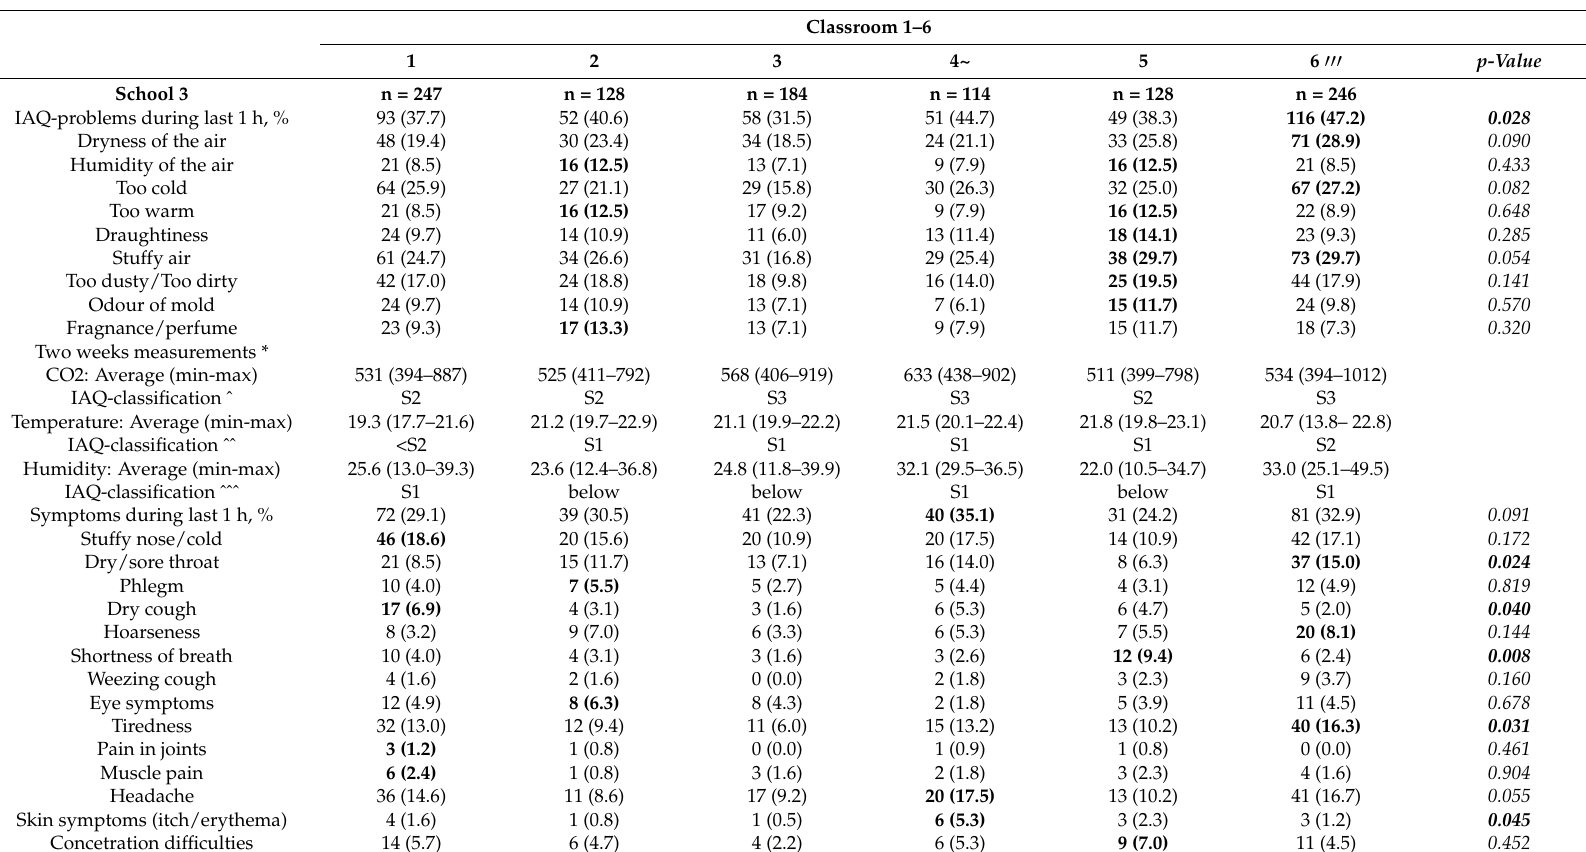
Table 6. Differences between the classrooms in the IAQ problems, and symptoms during the last hour among pupils and results of CO 2 , temperature, and relative humidity measurements in school